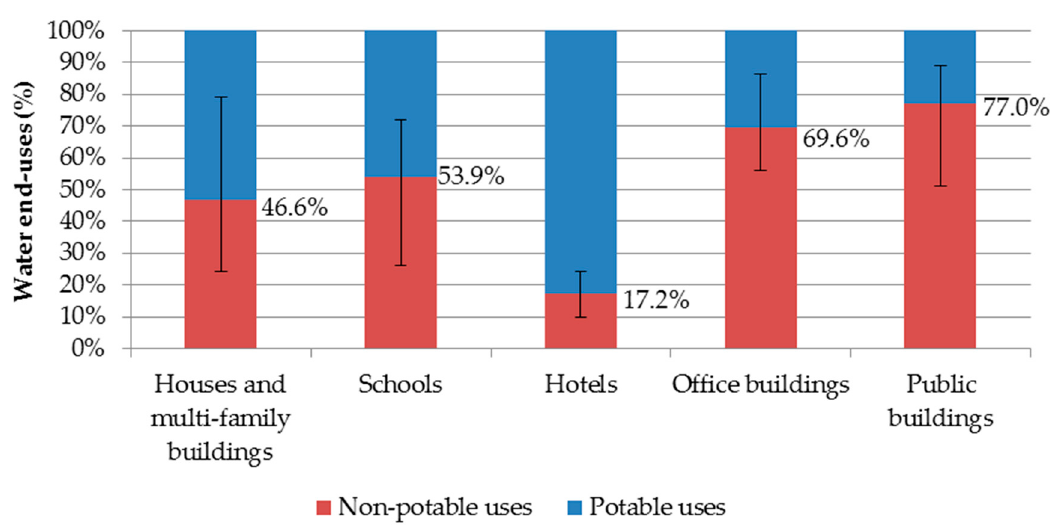
Figure 2. Potable and non-potable water end-uses in different types of buildings in